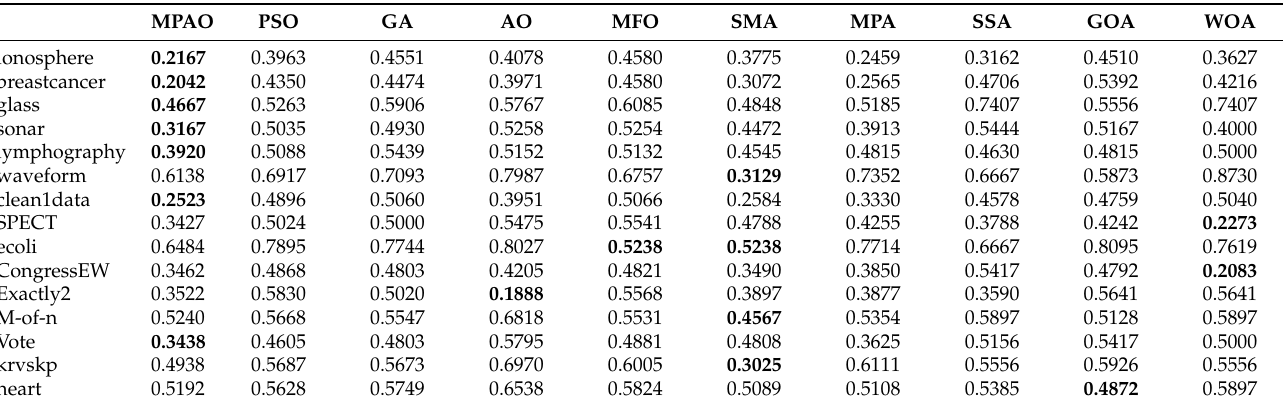
Table 11. Ratio of the selected feature for all